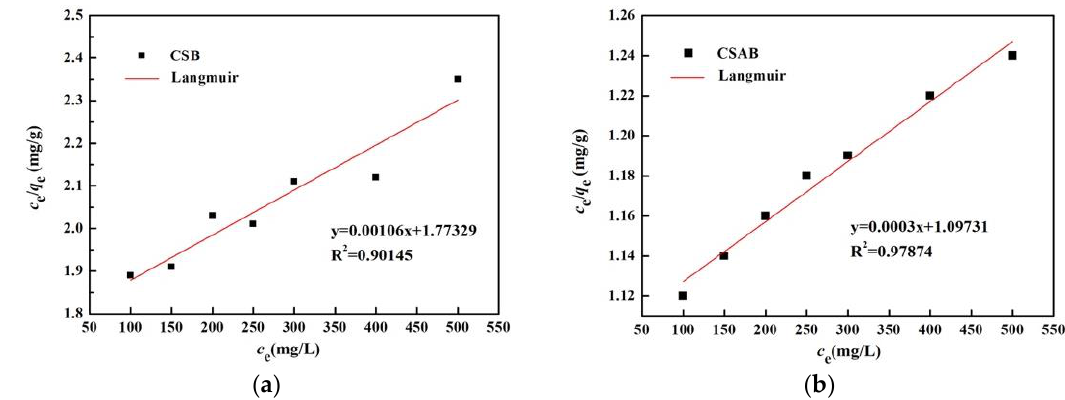
Figure 13. Langmuir isothermal adsorption equation fitting of diesel oil onto: ( a ) CSB, ( b ) CSAB.